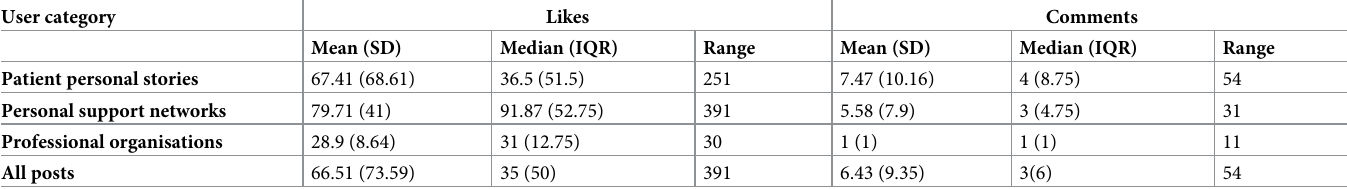
Table 4. Engagement with posts by user category as measured by likes and